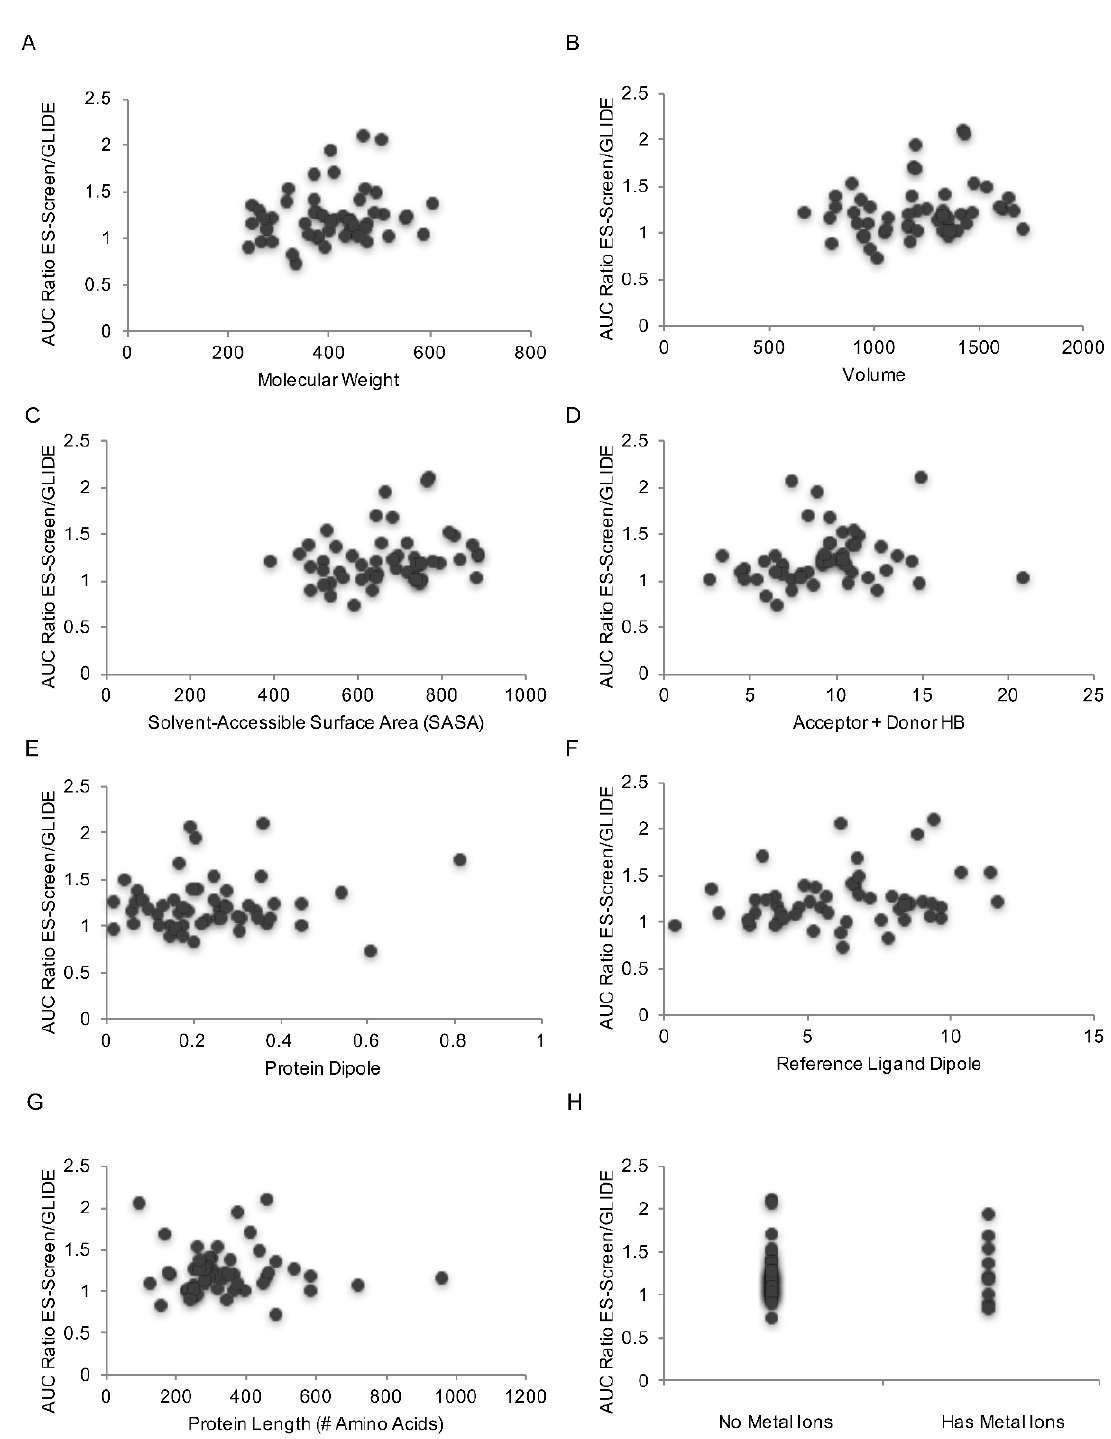
Figure 7. Trends in ES-Screen performance with respect to reference ligand and protein target physicochemical properties. Scatter plots of relative ES-Screen to GLIDE-SP docking performance for each protein target were studied against the following parameters: ( A ) reference ligand molecular weight, ( B ) reference ligand volume, ( C ) reference ligand solvent-accessible surface area (SASA), ( D ) reference ligand combined number of potential acceptor/donor hydrogen bonds, ( E ) protein dipole moment, ( F ) reference ligand dipole moment, ( G ) length of protein determined by a number of amino acids, and ( H ) presence of metal cations within the protein.